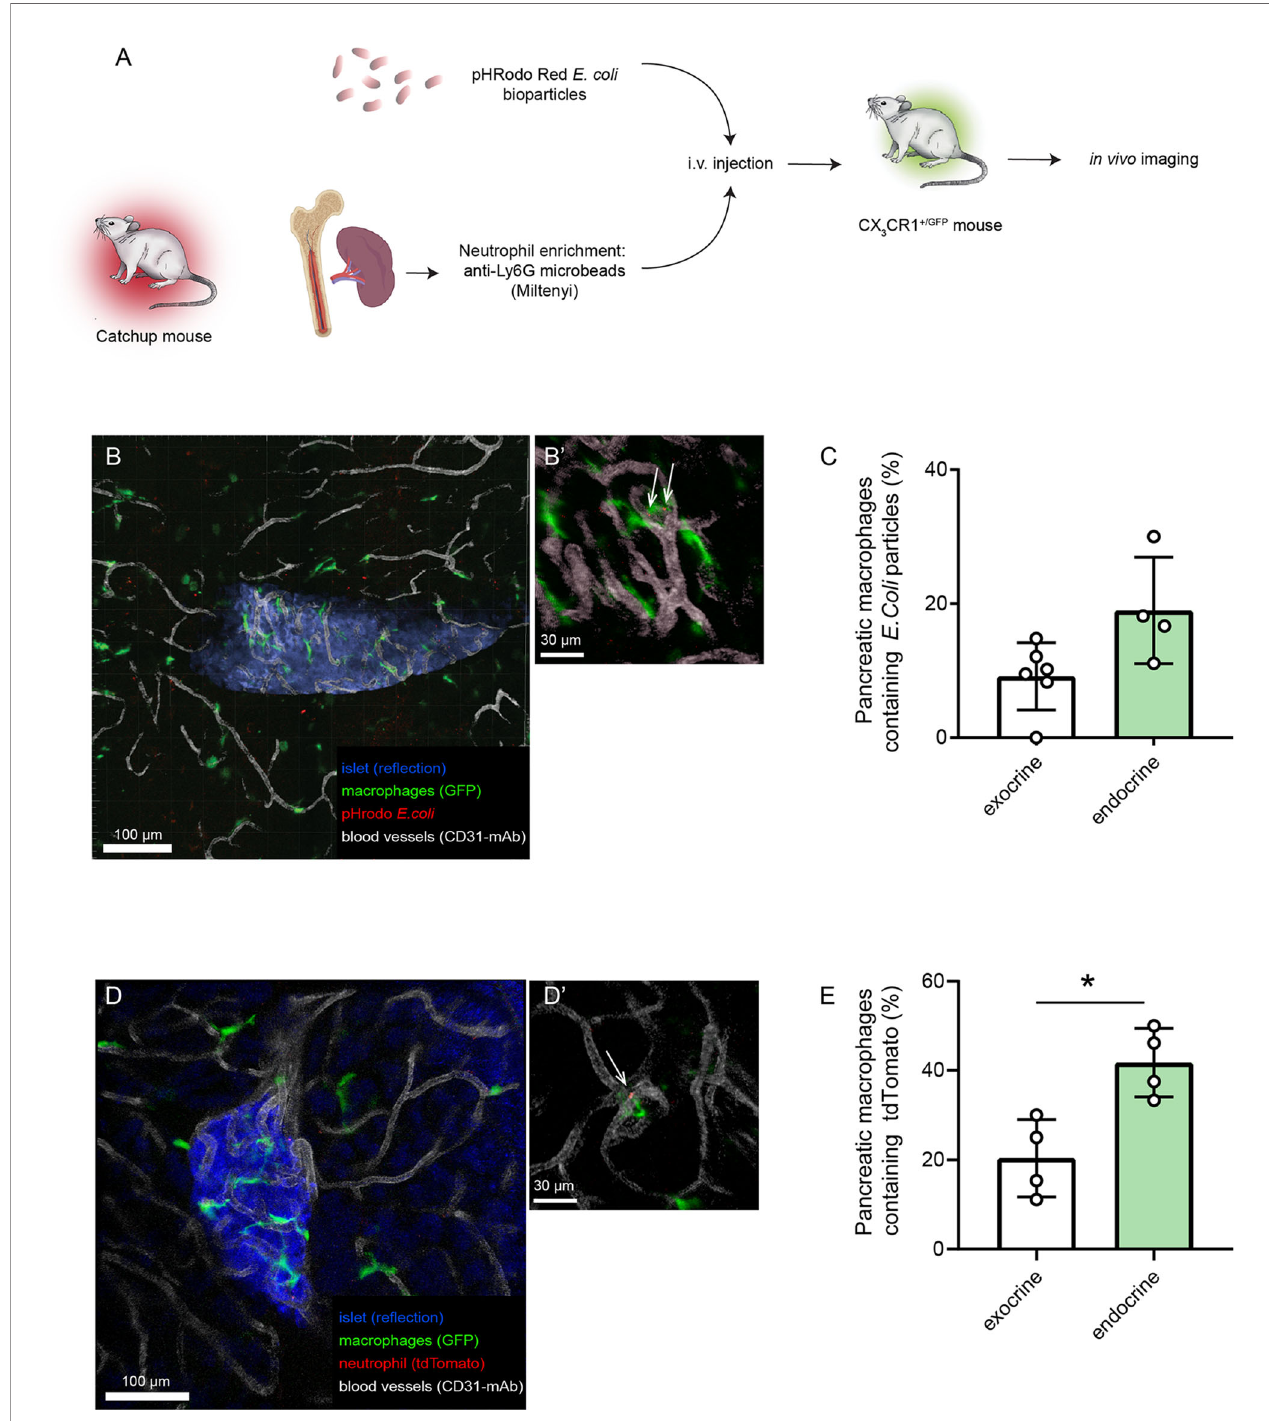
FIGURE 3 | Endocrine-resident macrophages are ef fi cient in phagocytosis and efferocytosis in vivo . (A) Schematic of work fl ow for in vivo assessment of phagocytosis and efferocytosis in pancreatic macrophages by intravital confocal imaging. (B) Confocal z-projection of an intravital recording showing an islet (blue), blood vessels (white), macrophages (green), and pHrodo E.coli bioparticles (red). (B ’ ) Closeup showing pHrodo signals within macrophages (arrows). (C) Quanti fi cation of phagocytosis in pancreatic macrophages (n=4, Mann-Whitney U test). (D) Confocal z-projection of an intravital recording showing an islet (blue), blood vessels (white), macrophages (green), and tdTomato-red particles of engulfed neutrophils (red). (D ’ ) Closeup showing tdTomato signal within a macrophage (arrow). (E) Quanti fi cation of efferocytosis in pancreatic macrophages (n=4, *P < 0.05, Mann-Whitney U